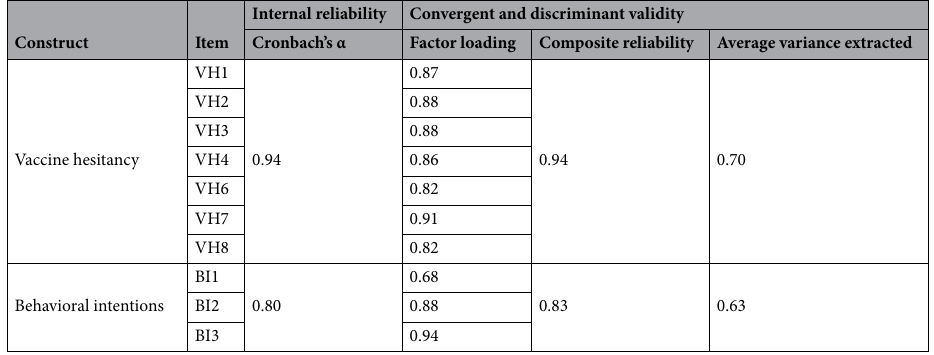
Table 6. Analysis of internal reliability and validities of the